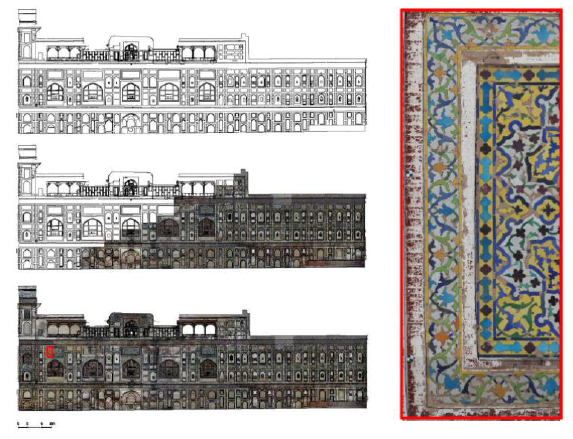
Figure 5. Photo rectification of the Picture Wall